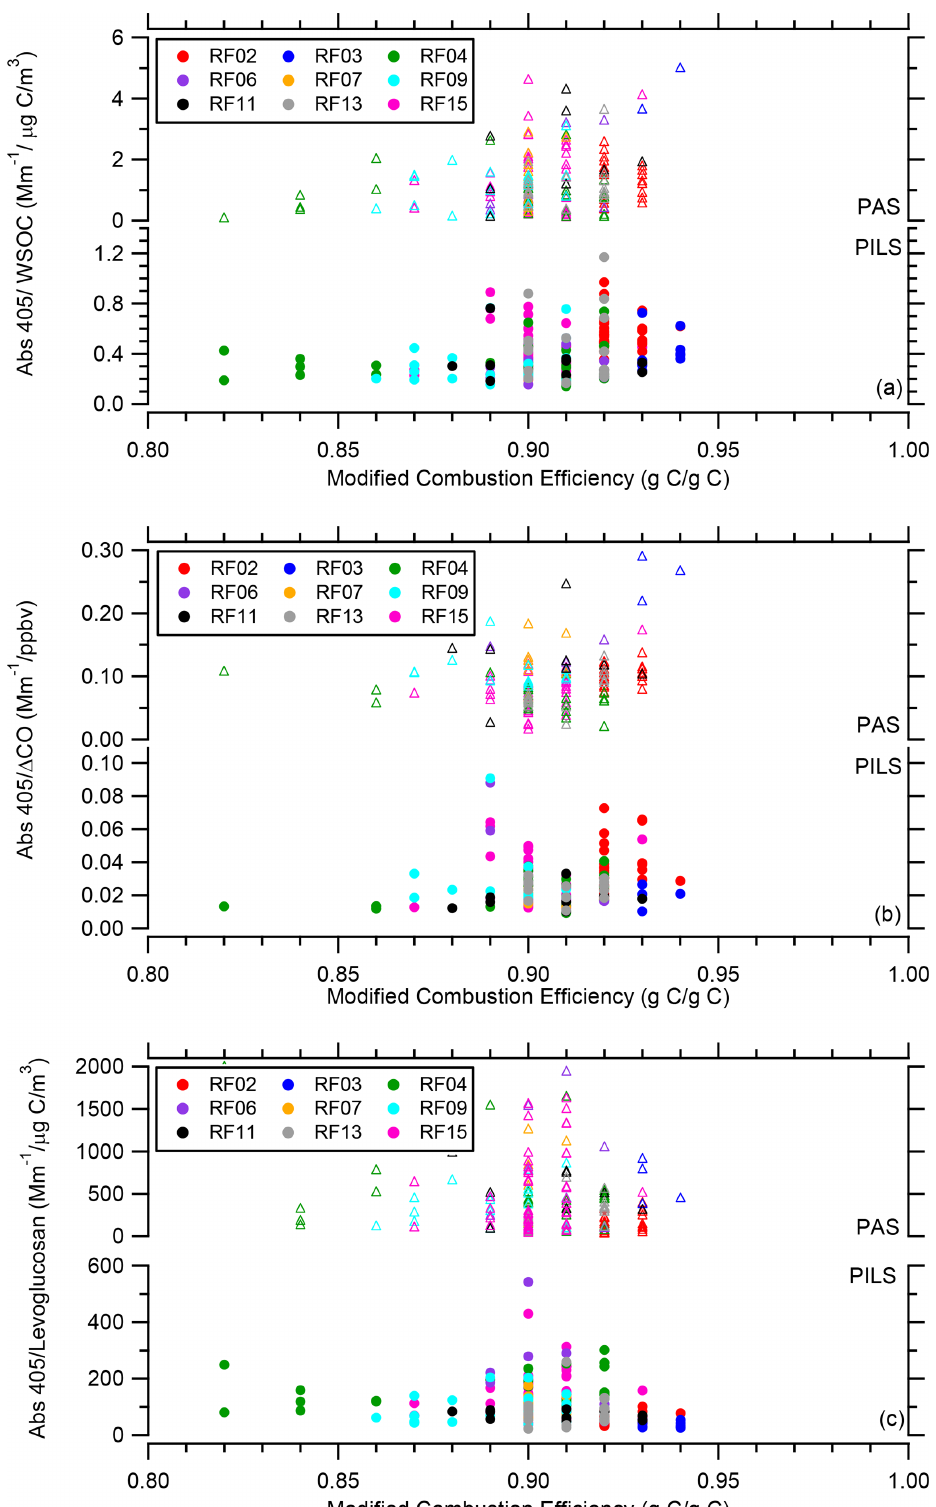
Figure 11. (a) Abs 405 / WSOC, (b) Abs 405 /(cid:49) CO, and (c) Abs 405 / levoglucosan as a function of modified combustion efficiency for all WE-CAN flights with the data segregated by flight. In each plot the PAS total Abs 405 BrC is on top and the PILS water-soluble Abs 405 on the